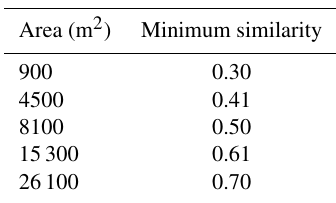
Table 3. Minimum similarities between observed and simulated re- sults for the year 2014.